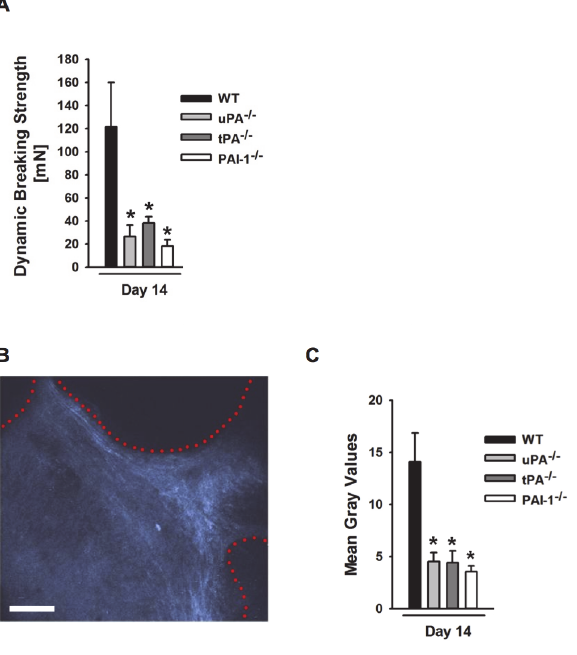
Figure 4. Role of endogenous uPA, tPA, and PAI-1 for mechanical tissue integration of PPE biomaterial. Panel ( A ) shows results for the disintegration force (mean ± SEM for n = 6; * p < 0.05 vs. WT). The disintegration force required for mechanical removal of the implant out of the host tissue was determined in WT as well as in uPA-, tPA-, or PAI-1-deficient mice. Collagen deposition within the PPE biomaterial was analyzed ex vivo in implants from WT as well as from uPA-, tPA-, or PAI-1-deficient mice by second harmonic imaging microscopy. A representative image from a WT mouse is shown ( B ; scale bar: 100 μ m; red dotted lines delineate pores of the implant material, in which collagen (white) is deposited). Panel ( C ) shows quantitative results for the second harmonic signal (mean ± SEM for n = 4; * p < 0.05 vs.